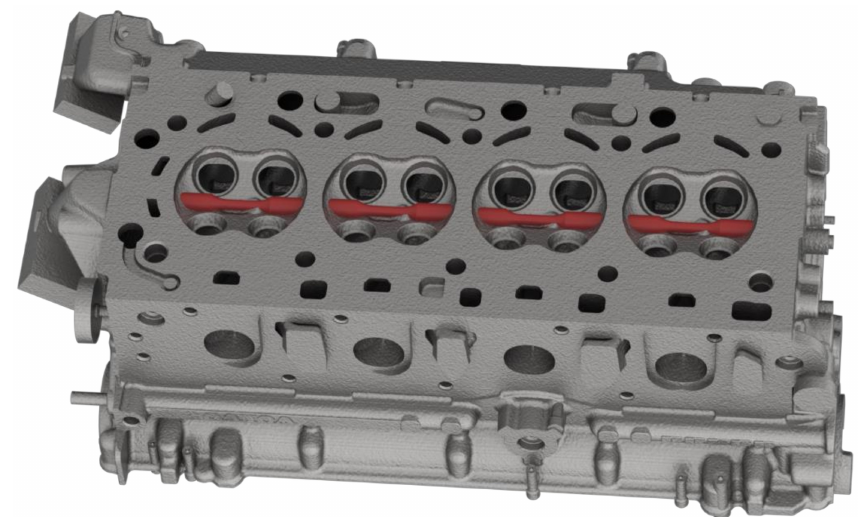
Figure 3. Sample extraction for testing from the valve bridge areas of the cylinder heads.